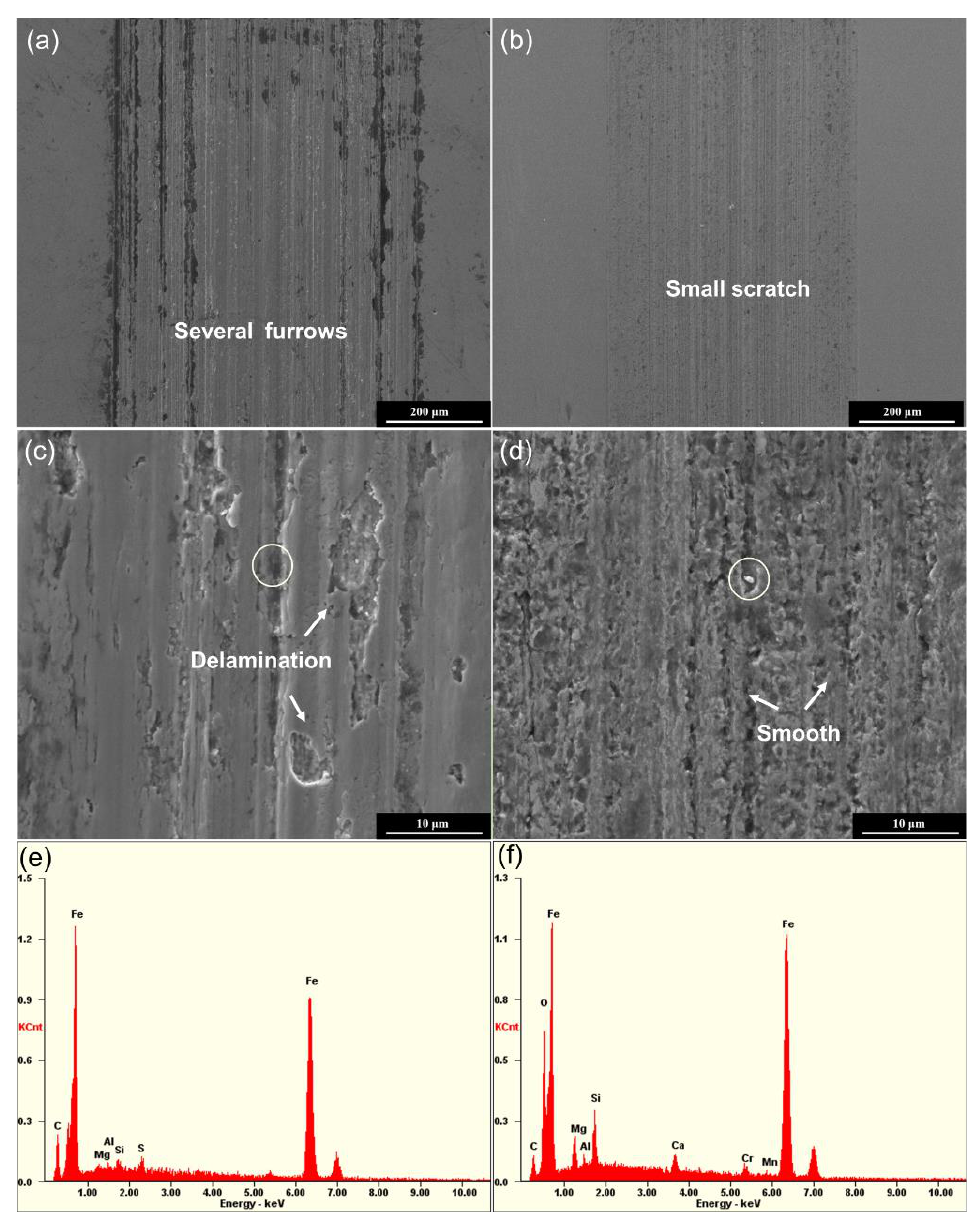
Figure 10. SEM images of wear tracks after the friction test of base grease ( a,c ) and the modified talc - based grease ( b , d ); EDS analysis of the wear tracks tested from the base grease ( e ) and the modified talc - based grease ( f ).